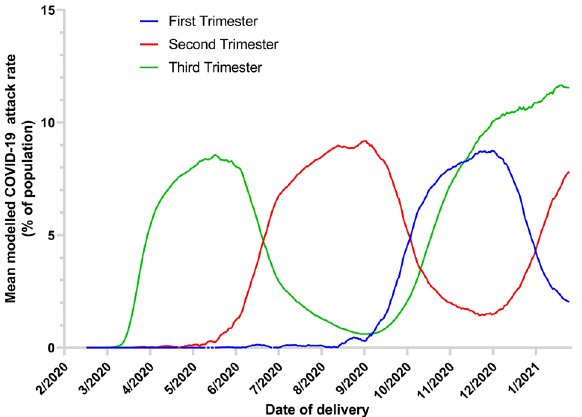
Figure 2. Changes in modelled cumulative COVID-19 exposure during pregnancy. A graph illustrating the average modelled risk of COVID-19 (expressed as attack rate, or the % of population contracting COVID-19 during a specified time interval, calculated from modelled transmission data 20 ) in each trimester of pregnancy, plotted against date of delivery between 17 February 2020 and 31 January 2021. The first trimester was defined as 0 to 12 + 6 weeks gestation, the second as 13 + 0 to 27 + 6 weeks, and the third as 28 + 0 weeks to delivery. Women exposed to COVID-19 in early pregnancy only delivered in the latter part of the study period.